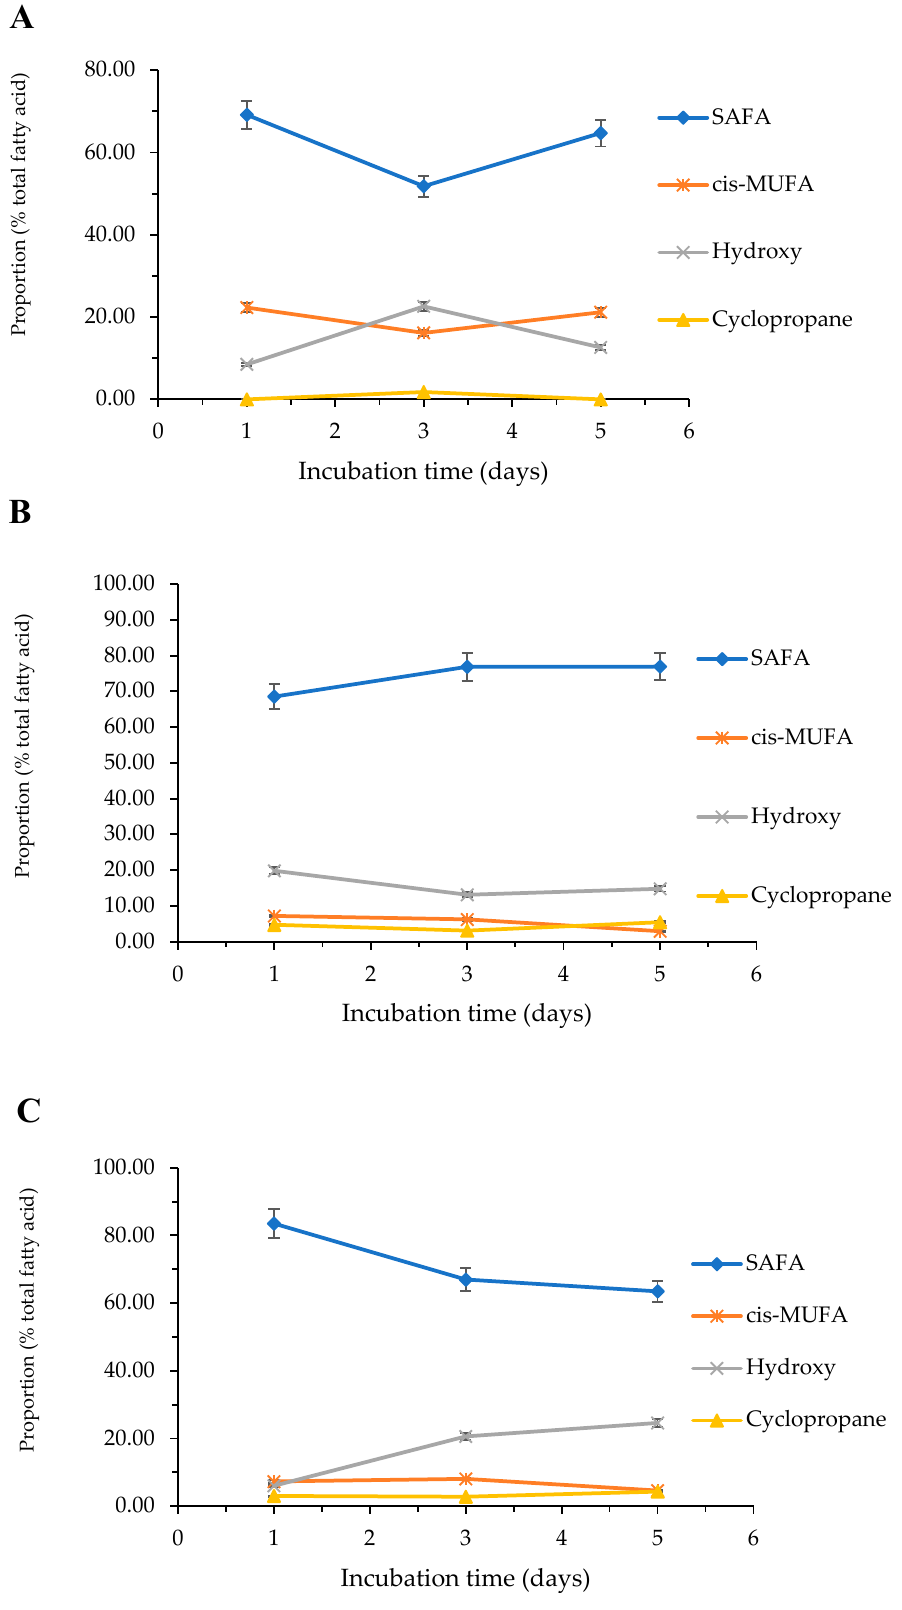
Figure 4. Influence of incubation time on the fatty acid proportion of P. aeruginosa ATCC 27853 grown at ( A ) 25 °C, ( B ) 37 °C and ( C ) 42 °C, using agar culture media (mean ± SD; n = 3). The optimized experimental conditions are detailed in Materials and Methods.